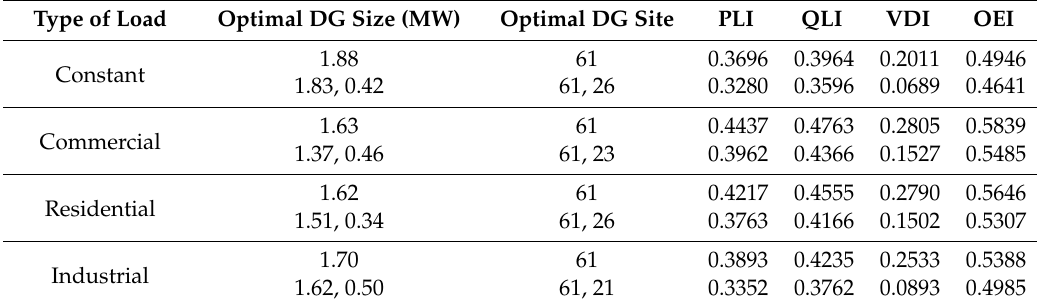
Table 2. Optimal size and site of DG and Indices values for power loss index (PLI) as objective.